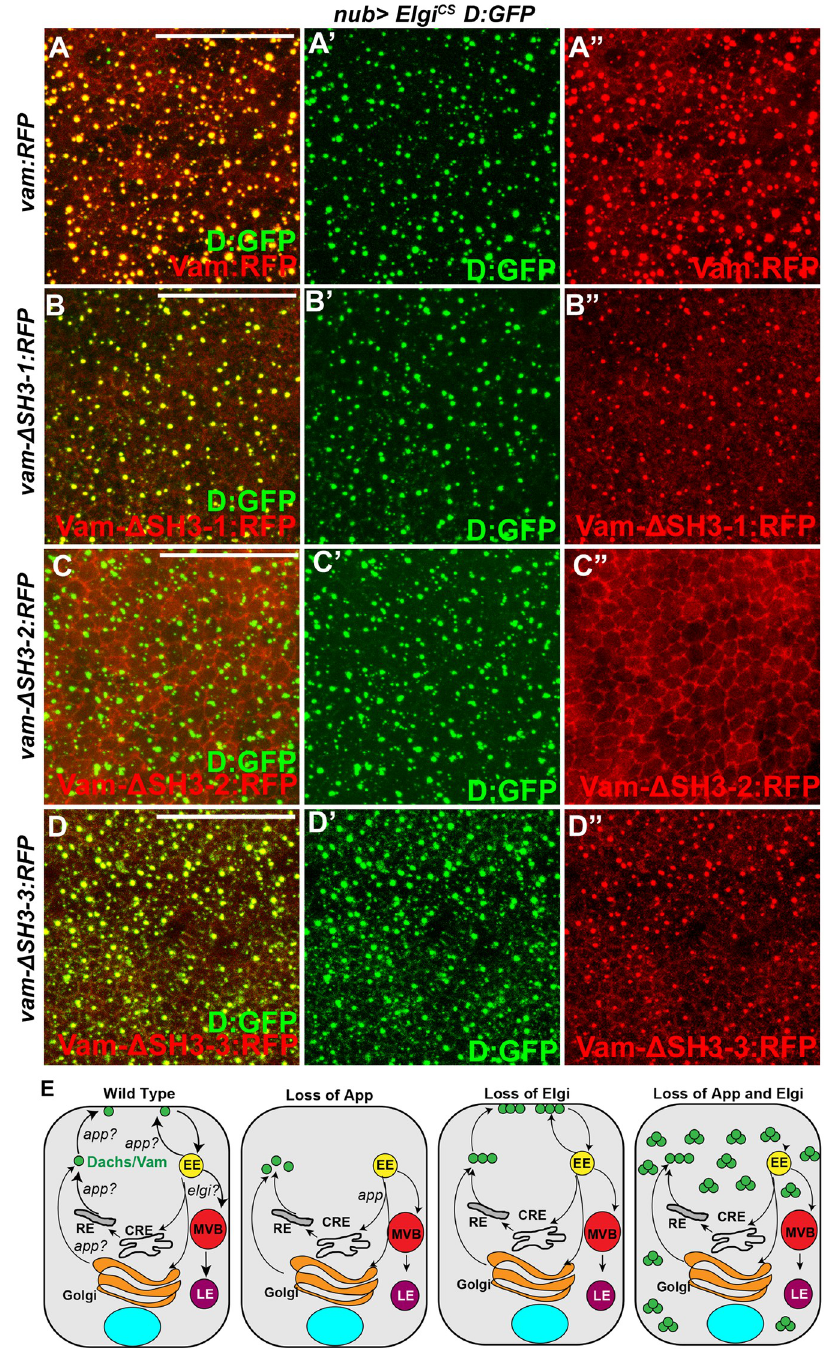
Fig 8. elgi CS affects Dachs rather than Vam. (A-D) Horizontal apical sections of wing imaginal discs expressing nub- Gal4 UAS-elgi CS D : GFP along with either UAS-vam-RFP (A, A’, A”), or UAS-vam- Δ -SH3-1-RFP (B, B’, B”), UAS-vam- Δ -SH3-2-RFP (C, C’, C”) or UAS-vam- Δ -SH3-3-RFP (D, D’, D”) showing how the different SH3 domains of Vam (red) affect its co-localization with Dachs:GFP (D:GFP) (green) in the presence of elgi CS . (E) Schematic illustrating model showing that under normal conditions Elgi maintains limiting levels of Dachs (green circles) which localizes to the membrane in an App-dependent manner. In absence of App, Dachs is mostly found in the cytoplasm in a diffuse manner and in absence of Elgi there is higher amount of Dachs, but the endogenous App is sufficient to promote its membrane localization. However, in absence of both, there is excessive Dachs that fails to localize to the membrane and accumulates in punctae in the cytoplasm. Elgi might regulate lysosomal trafficking of a Dachs/Vam complex,